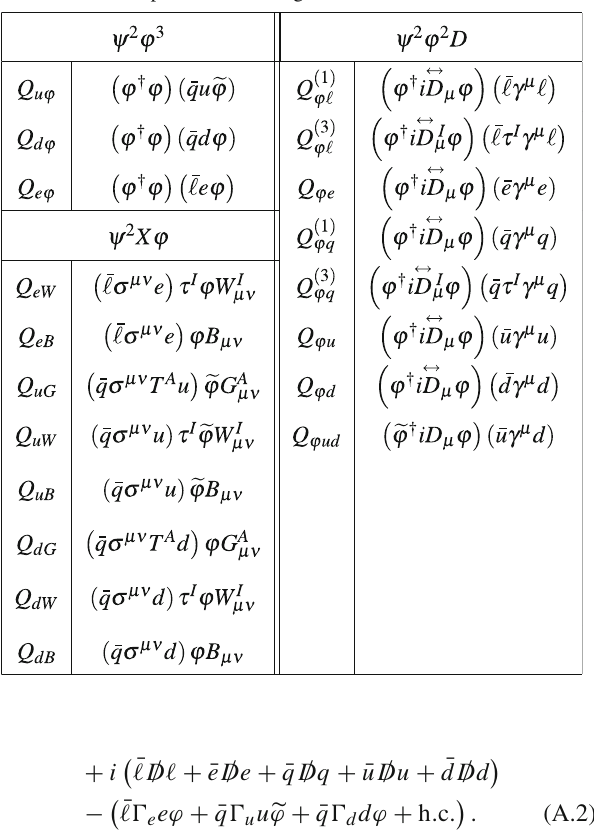
Table 2 Mixed operators involving bosons and